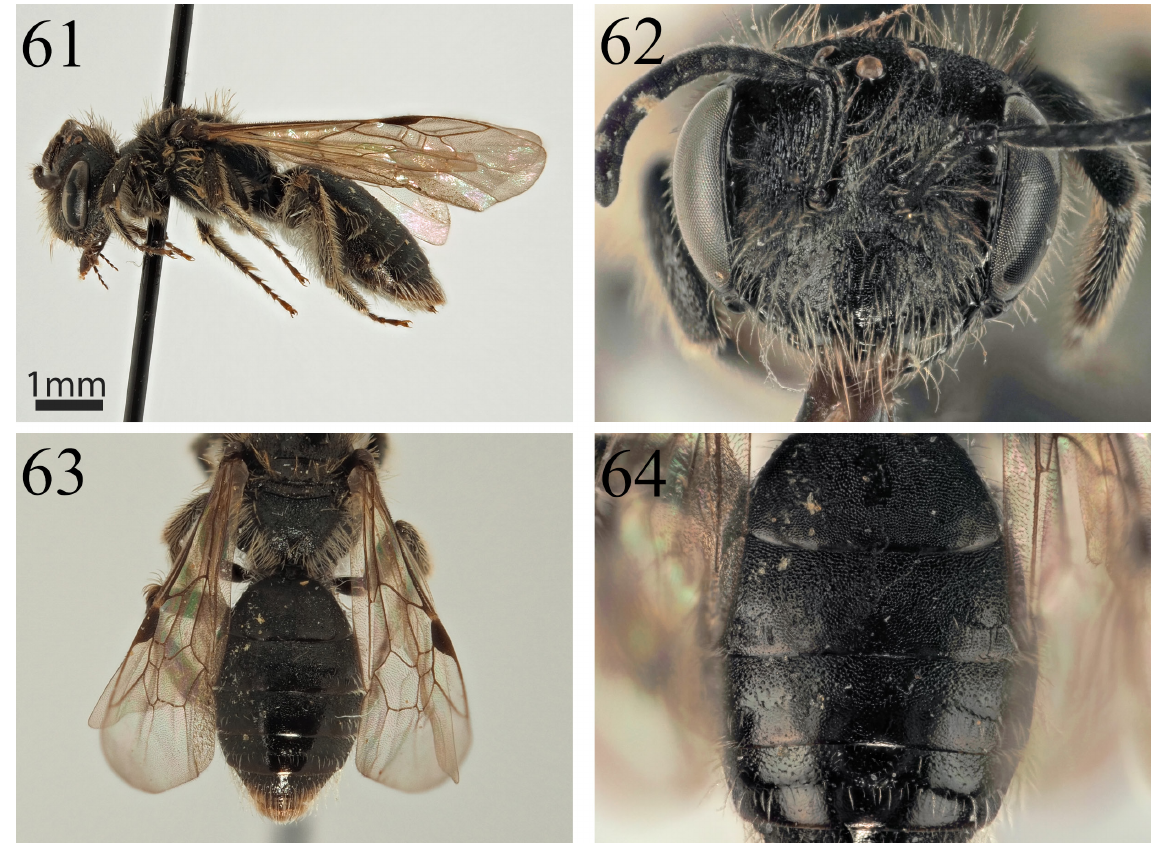
Figs 61–64. Andrena subviridula Wood sp. nov., ♀ (OÖLM). 61 . Profile. 62 . Face. 63 . Terga. 64 . Terga,